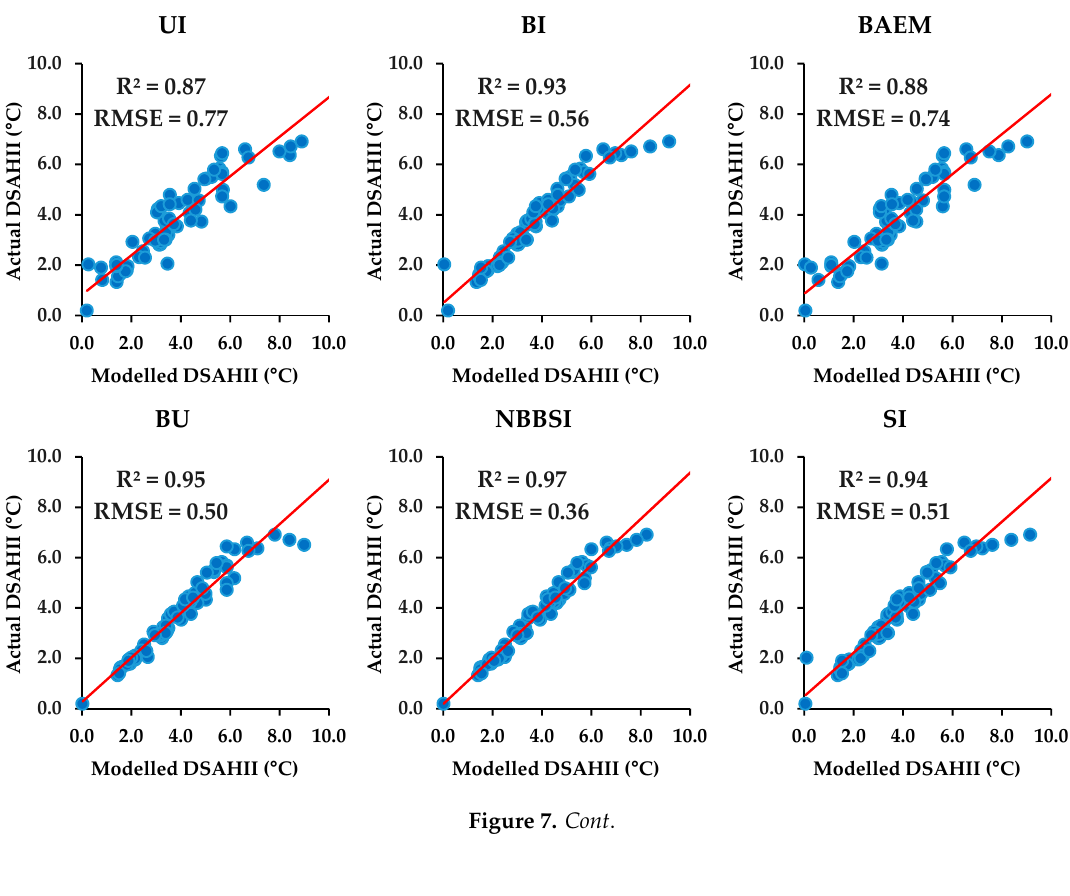
BCI Figure 7. The obtained R 2 and root mean square error (RMSE) values between the actual and modelled DSAHII based on spectral index-based ISC (SIISC). Solid red line represents the predicted relationship between actual and modeled DSAHII.